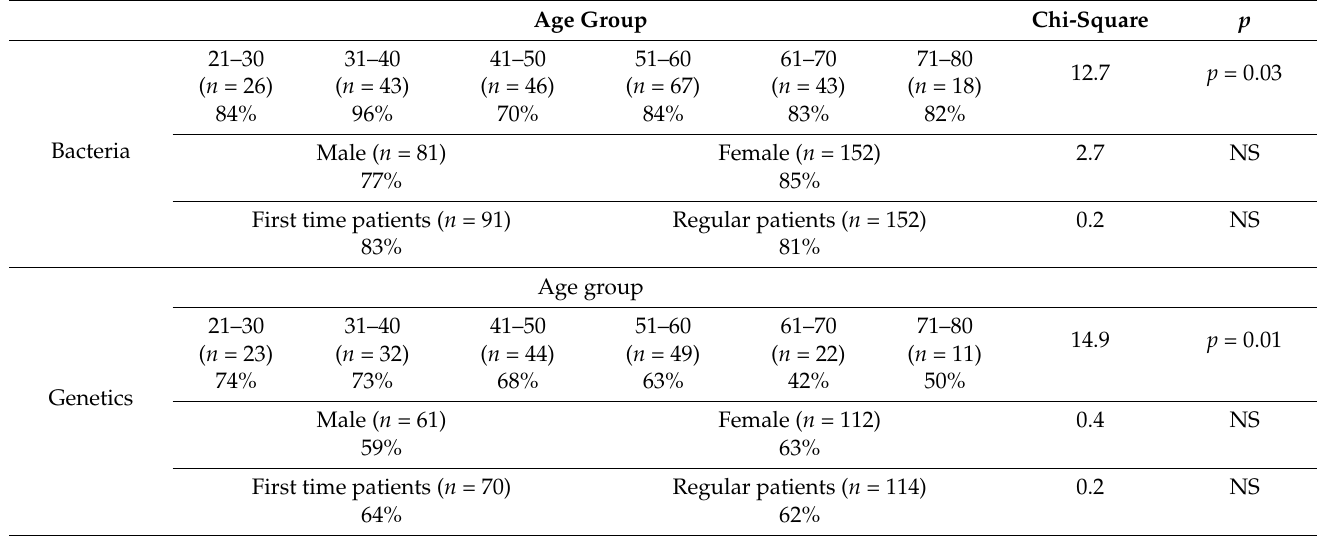
Table 3. Patient’s knowledge about the influence of risk factors on the occurrence of periodontal disease. Age Group